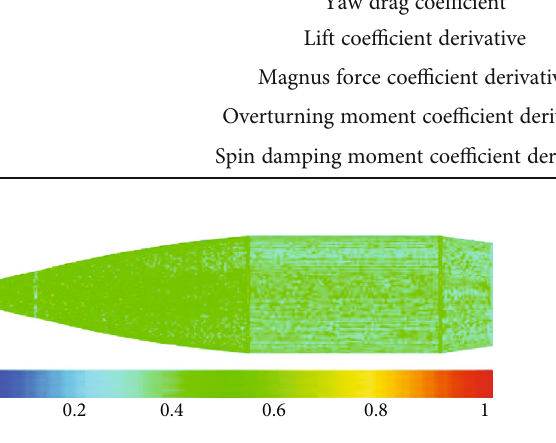
Figure 4: M107 geometry and wall unit, y + distribution.